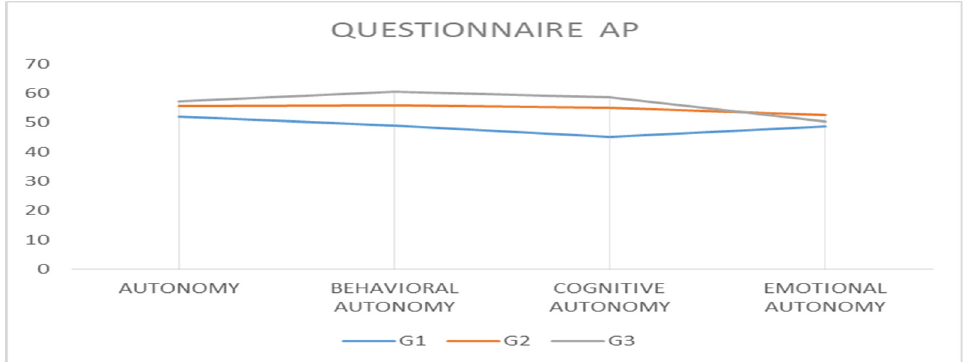
Figure 3. Representation of the arithmetic means recorded by the three groups for each PAQ subscale.